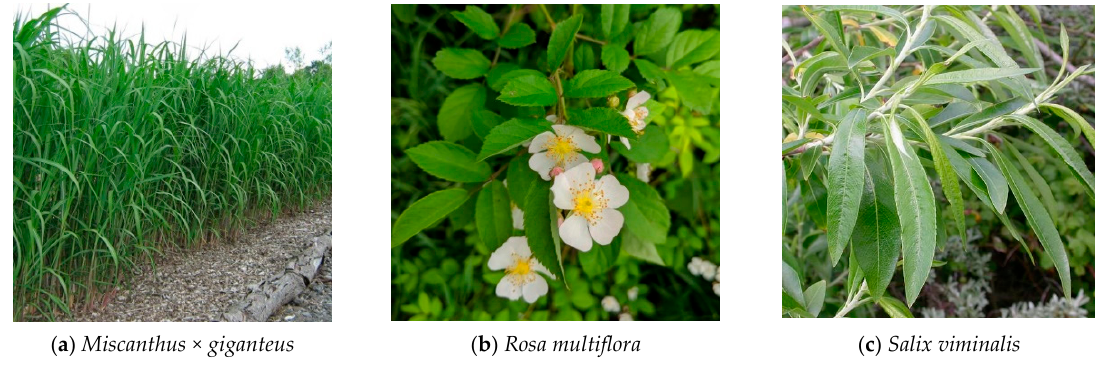
Figure 1. Biomass investigated in the study.